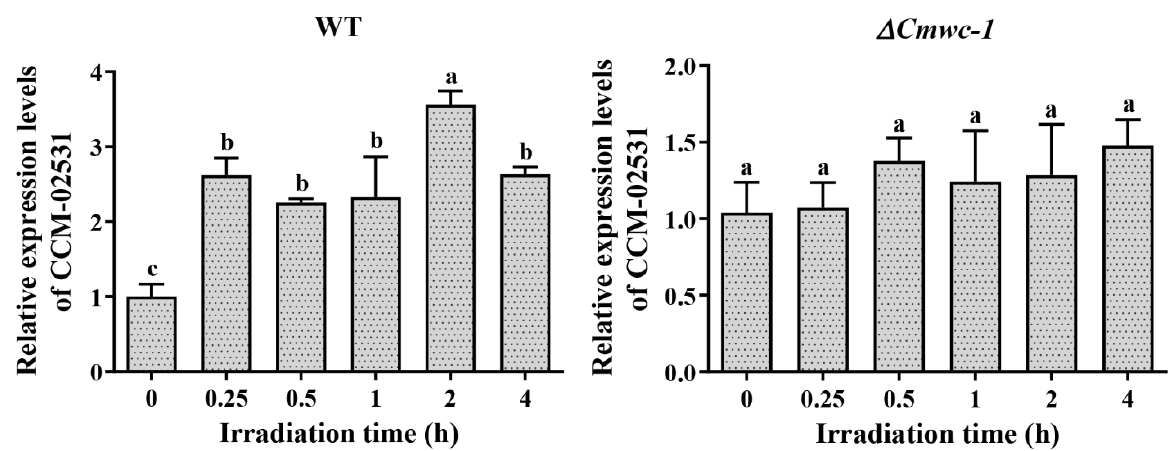
Figure 9. The expression levels of CCM_02531 in the WT and ∆ Cmwc-1 strains after light exposure revealed by qPCR. The relative expression levels of each gene in the different light exposure time were based on the standard levels of the light exposure time of 0 (under dark) in the WT and deletion mutants, respectively. Error bars indicate the standard deviations of biological replicates with two technical replicates. The different letters over the histogram indicate significant differences at p < 0.05.